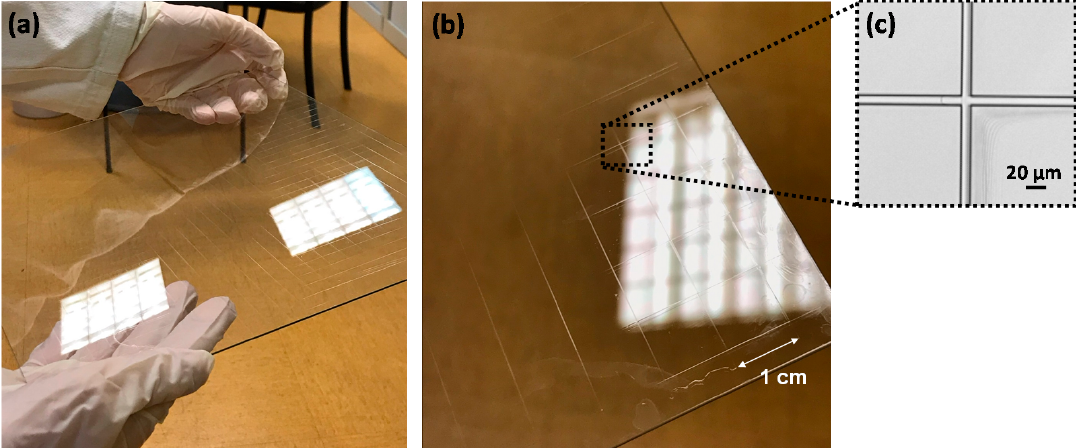
Figure 9. TiO 2 –SiO 2 grid architecture on a large substrate composed of 62 guides. ( a ) Overview of the sensor, ( b ) corresponding zoom showing the 1 cm separation between two consecutive lines and ( c ) microscope image of the doubled exposed zone.